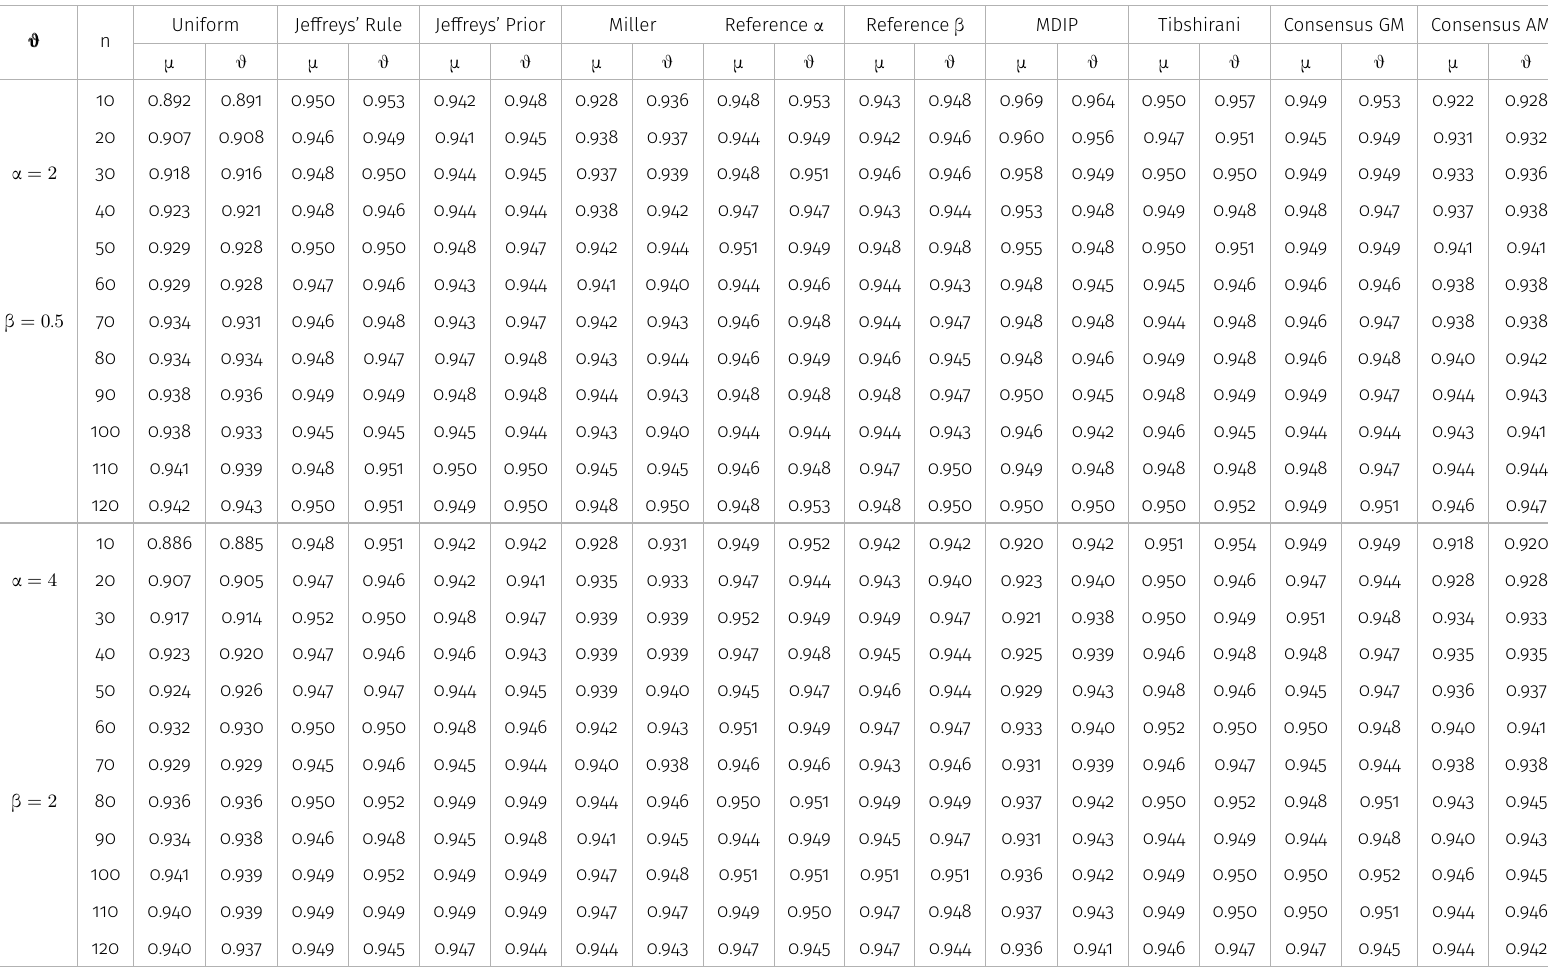
Table I. The CP 95 % CP 95 % CP 95 % from the estimates of μμμ and ΩΩΩ considering different values of nnn with N = 10,000 simulated